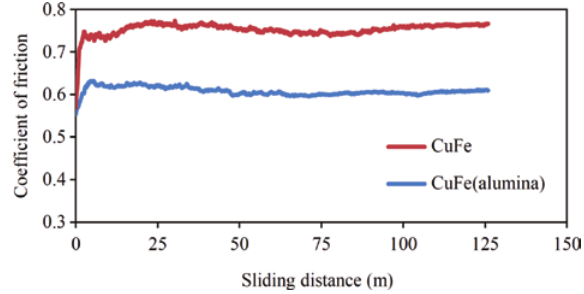
Figure 8: Coefficient of friction for CuFe alloy and CuFe(alumina) nanocomposite-sintered samples.